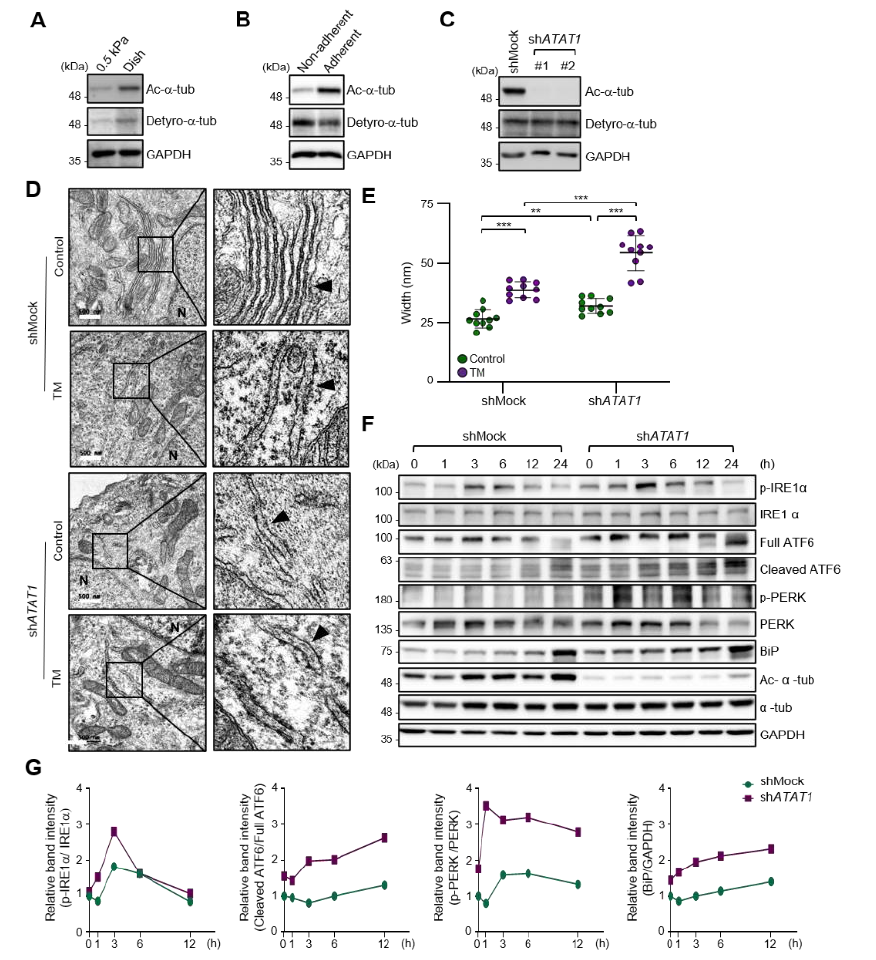
Figure 2. ECM stiffness-dependent microtubule acetylation regulates ER stress response signaling. ( A ) Western blot analysis of acetylated and detyrosinated α-tubulin levels in MDA-MB-231 cells cultured on 0.5 kPa PAGs or culture dishes for 48 h. ( B ) Western blot analysis of acetylated and detyrosinated α-tubulin levels in MDA-MB-231 cells cultured on non-adherent or adherent plates for 48 h. ( C ) Western blot analysis of ATAT1 KD efficiency in sh ATAT1 #1- and #2-treated MDA- MB-231 cells compared to shMock-treated cells. ( D ) Transmission electron microscopy of shMock-